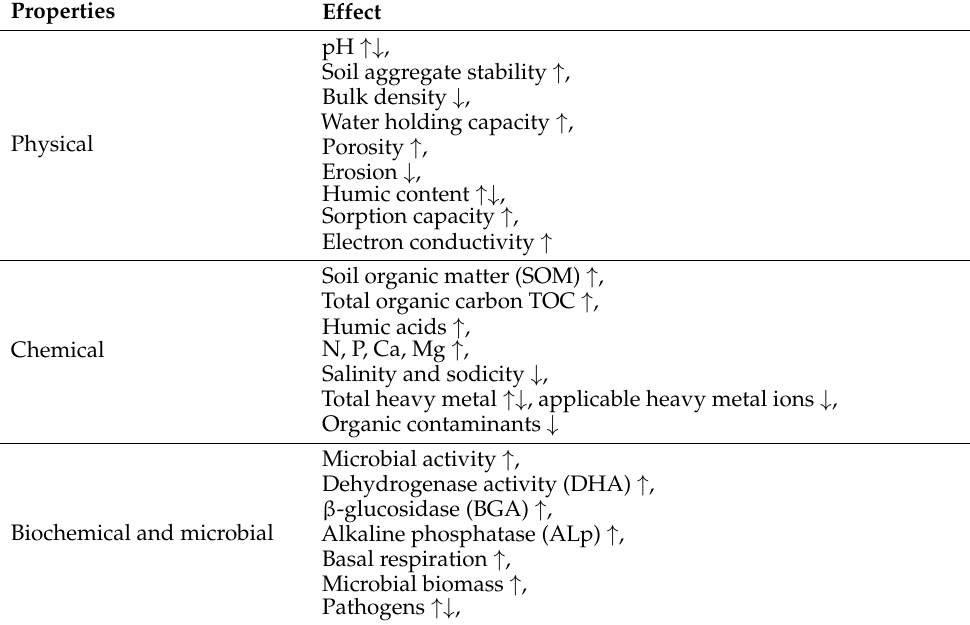
Table 4. Effects of the organic amendments on the properties of degraded soil